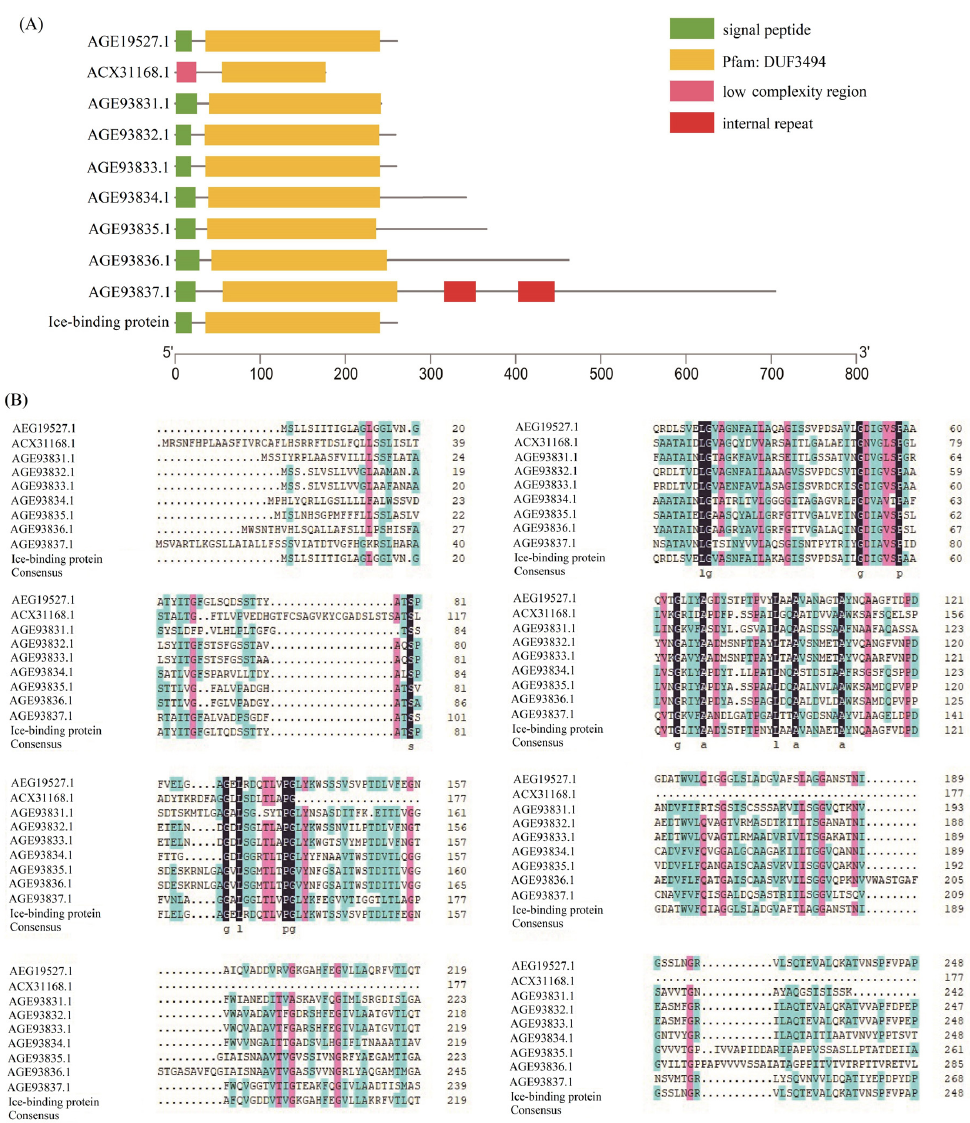
Figure 3. Domains and sequence alignments of AFPs from G. antarctica PI12 and Leucosporidium spp. ( A ) Domains of AFPs. ( B ) Sequence alignments of AFPs.